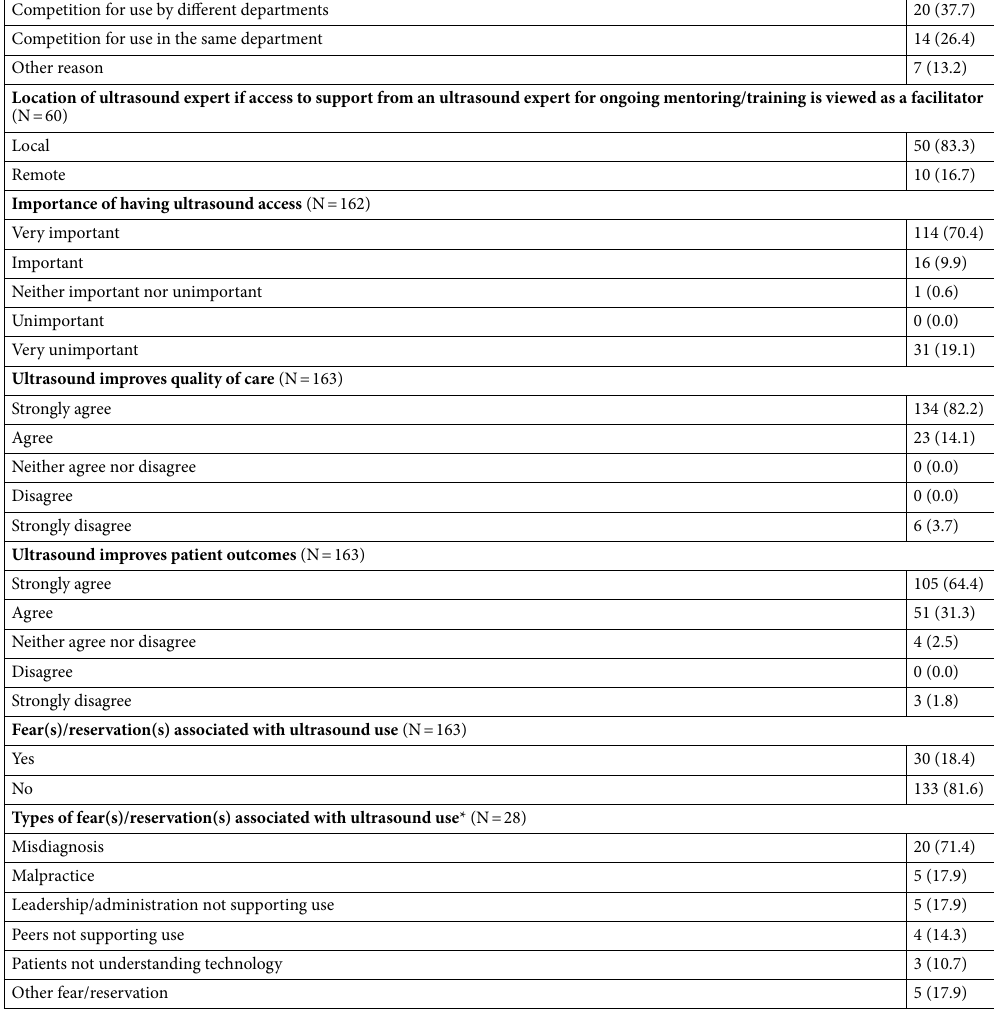
Table 5. Respondent opinions on ultrasound use in low- and middle-income countries. *Total percentage for individual question may be over 100% due to “Check all that apply” option for that question on the survey. The value for N provided for “Check all that apply” questions represents the number of